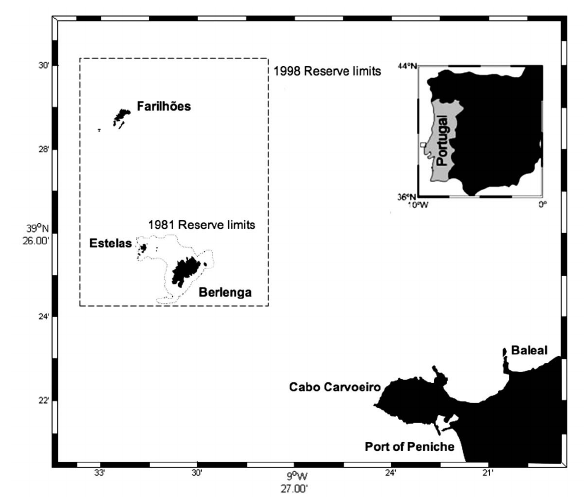
Fig . 1. – Location of the Berlengas Nature Reserve relative to Cabo Carvoeiro and mainland Portugal (inset). The reserve limits (1981 and 1998) are shown as dotted lines in the